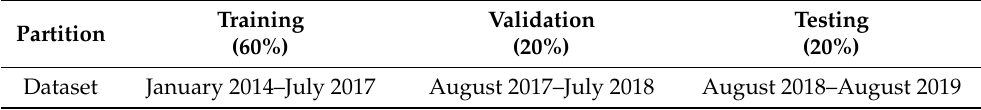
Table 2. Data partition for